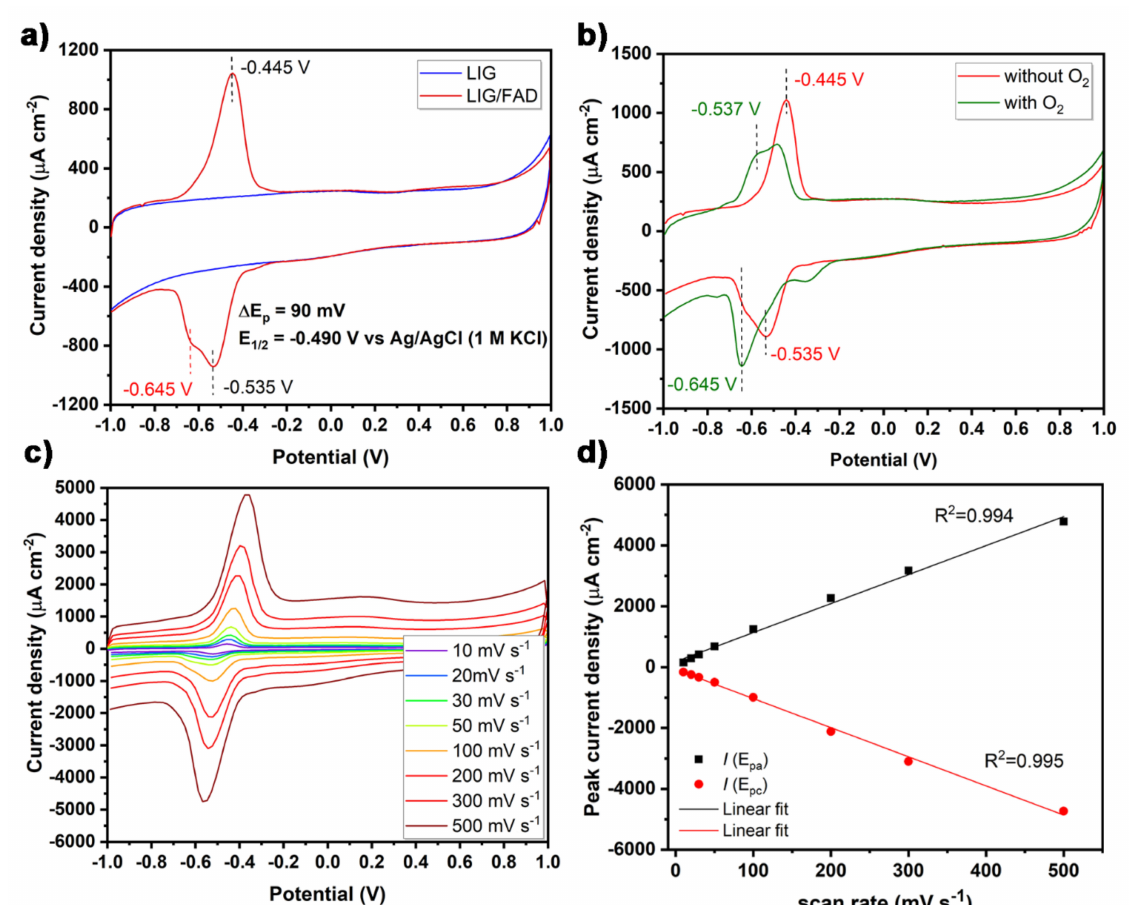
Figure 4. Cyclic voltammograms of ( a ) LIG before and after FAD adsorption, without O 2 , and ( b ) of LIG/FAD electrodes in the presence and absence of O 2 . ( c ) Cyclic voltammograms at different scan rates for the LIG/FAD electrode and ( d ) the respective intensity of current for anodic, I (E pa ), and cathodic, I (E pc ), peaks as a function of the scan rate.